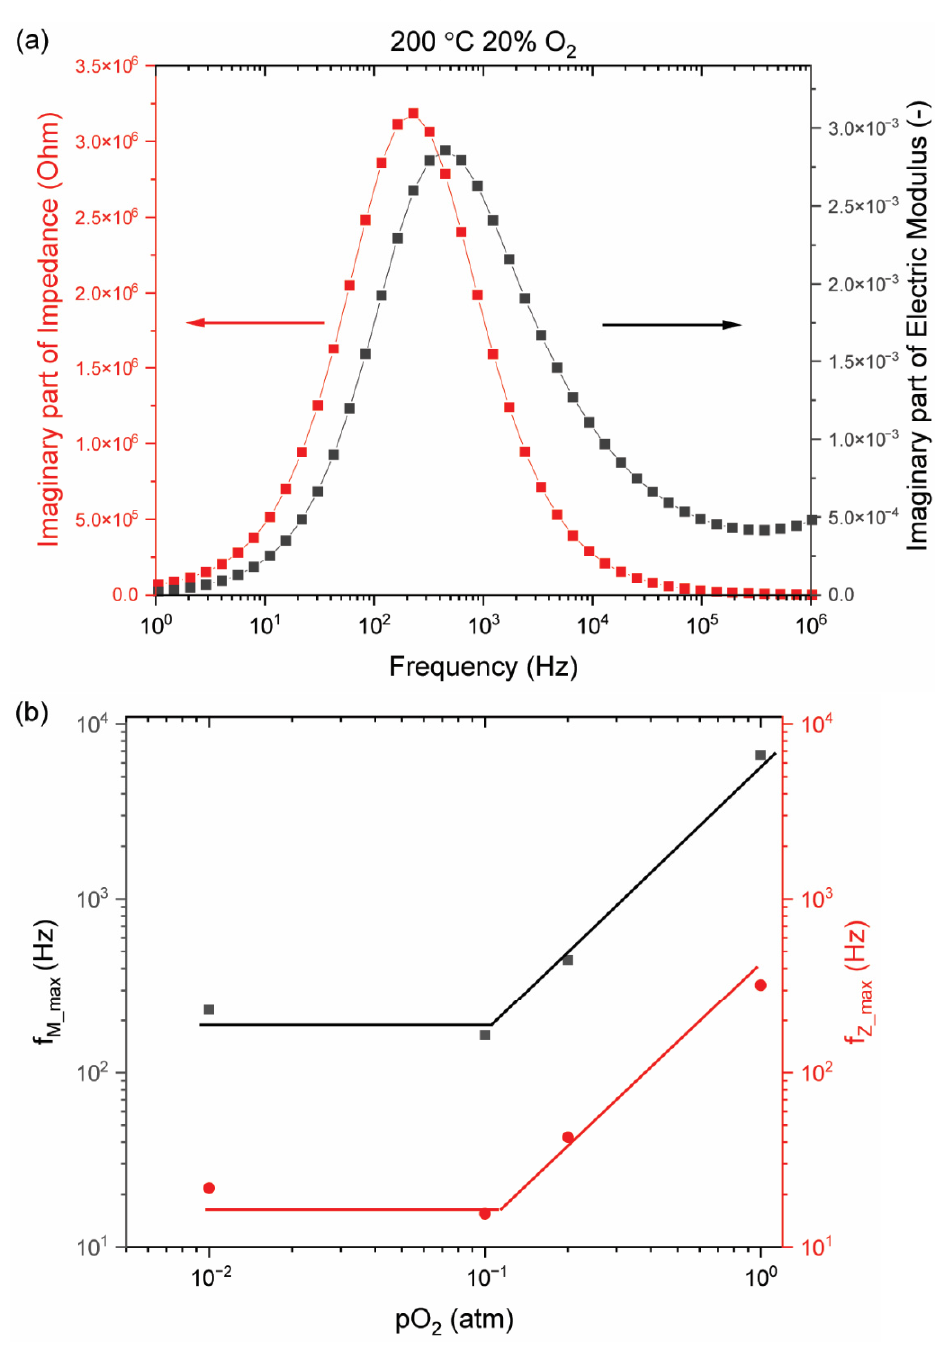
Figure 7. Results of impedance spectroscopy analysis for data measured at 200 °C. ( a ) Impedance and electric modulus spectroscopic plots for samples annealed in 20% O 2 ; ( b ) electrical modulus peak and impedance peak frequency as a function of pO 2 .